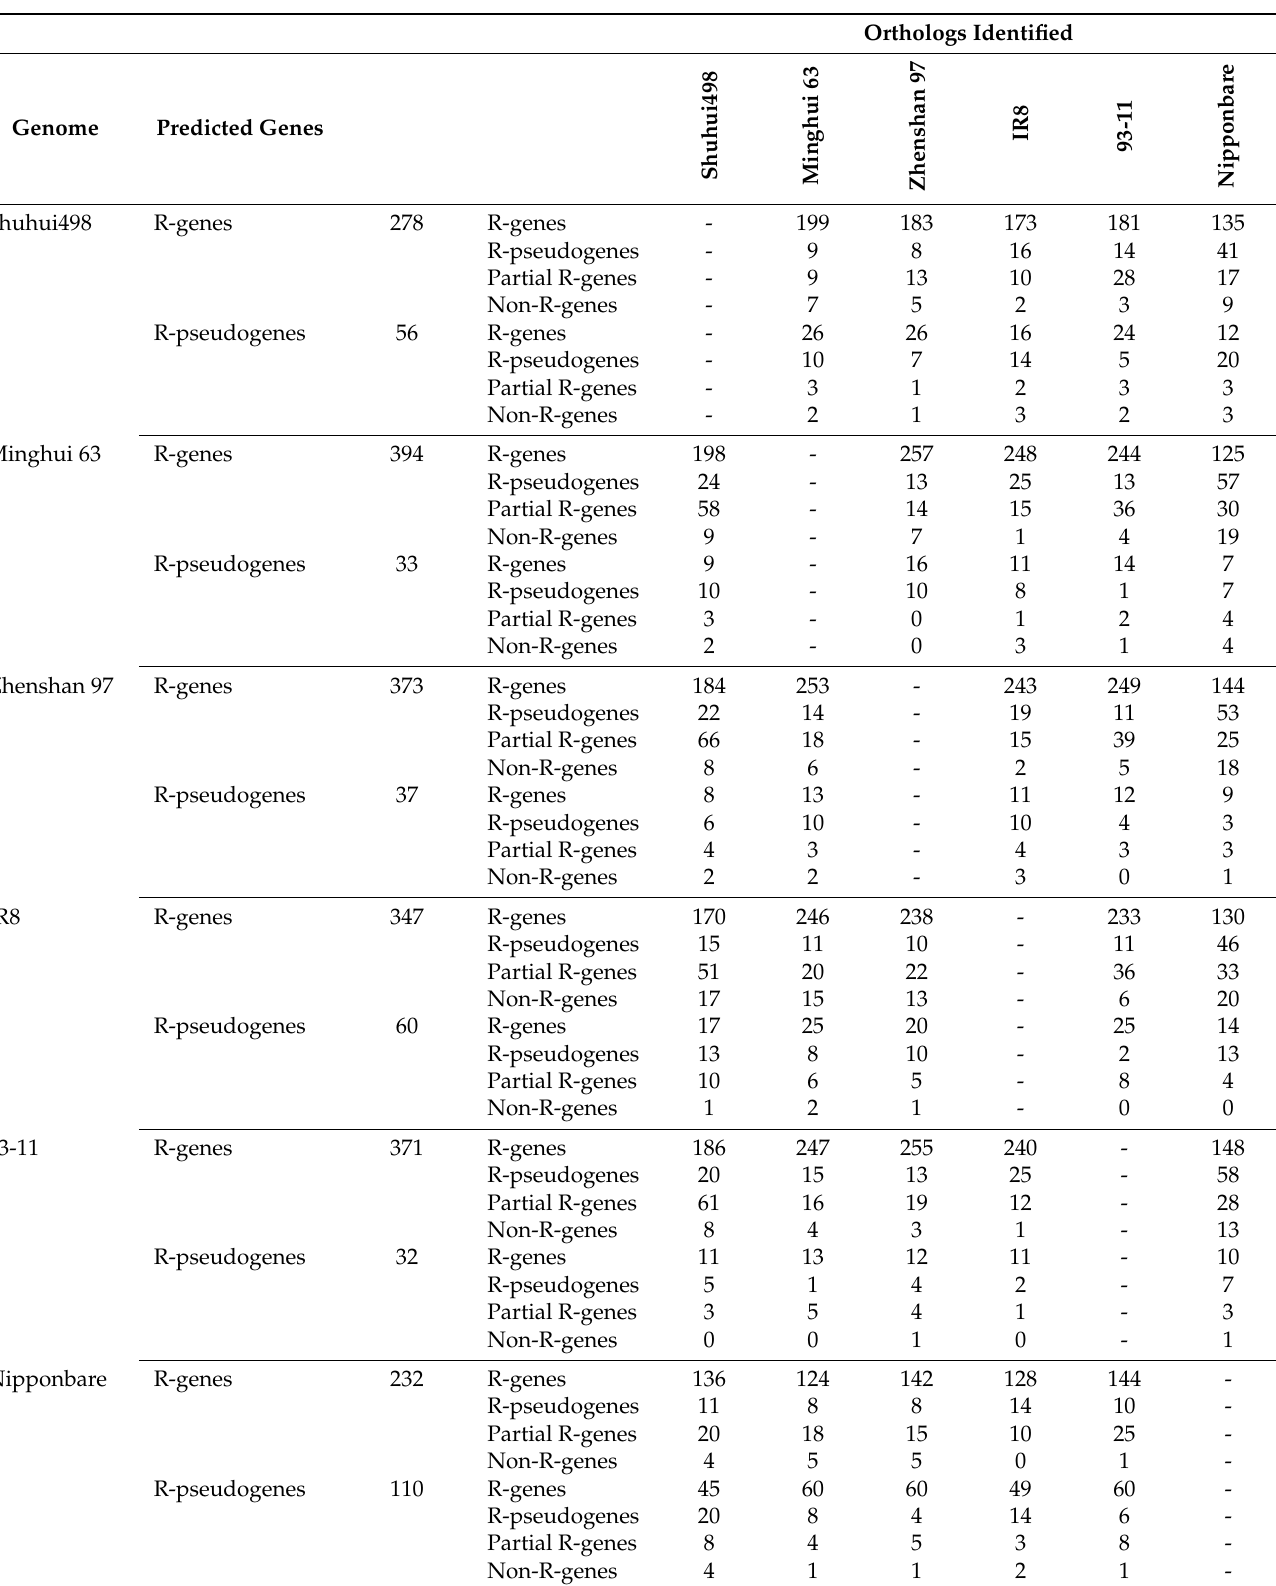
Table 3. Number of orthologs of R-genes and R-pseudogenes identified by JustOrthologs search of CDS sequences and reciprocal BLAST of gene DNA